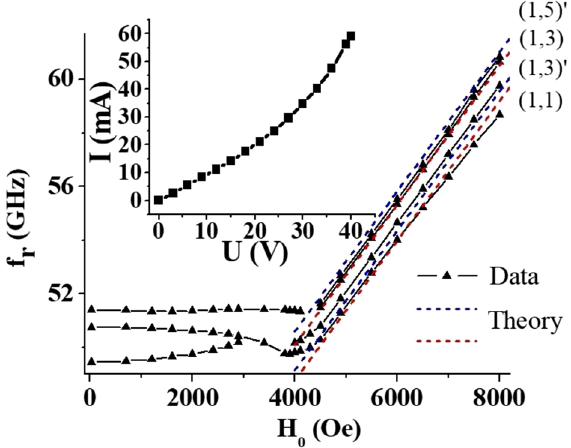
Figure 2. Characterization of magnetic and electric properties of hexaferrite materials in the case of SrFe 12 O 19 . Frequency vs. field dependence for magnetostatic modes of strontium hexaferrite sample in multidomain and saturated states. Symbols represent the data and dashed lines are theoretical estimates. Inset shows current– voltage characteristic of the given hexaferrite